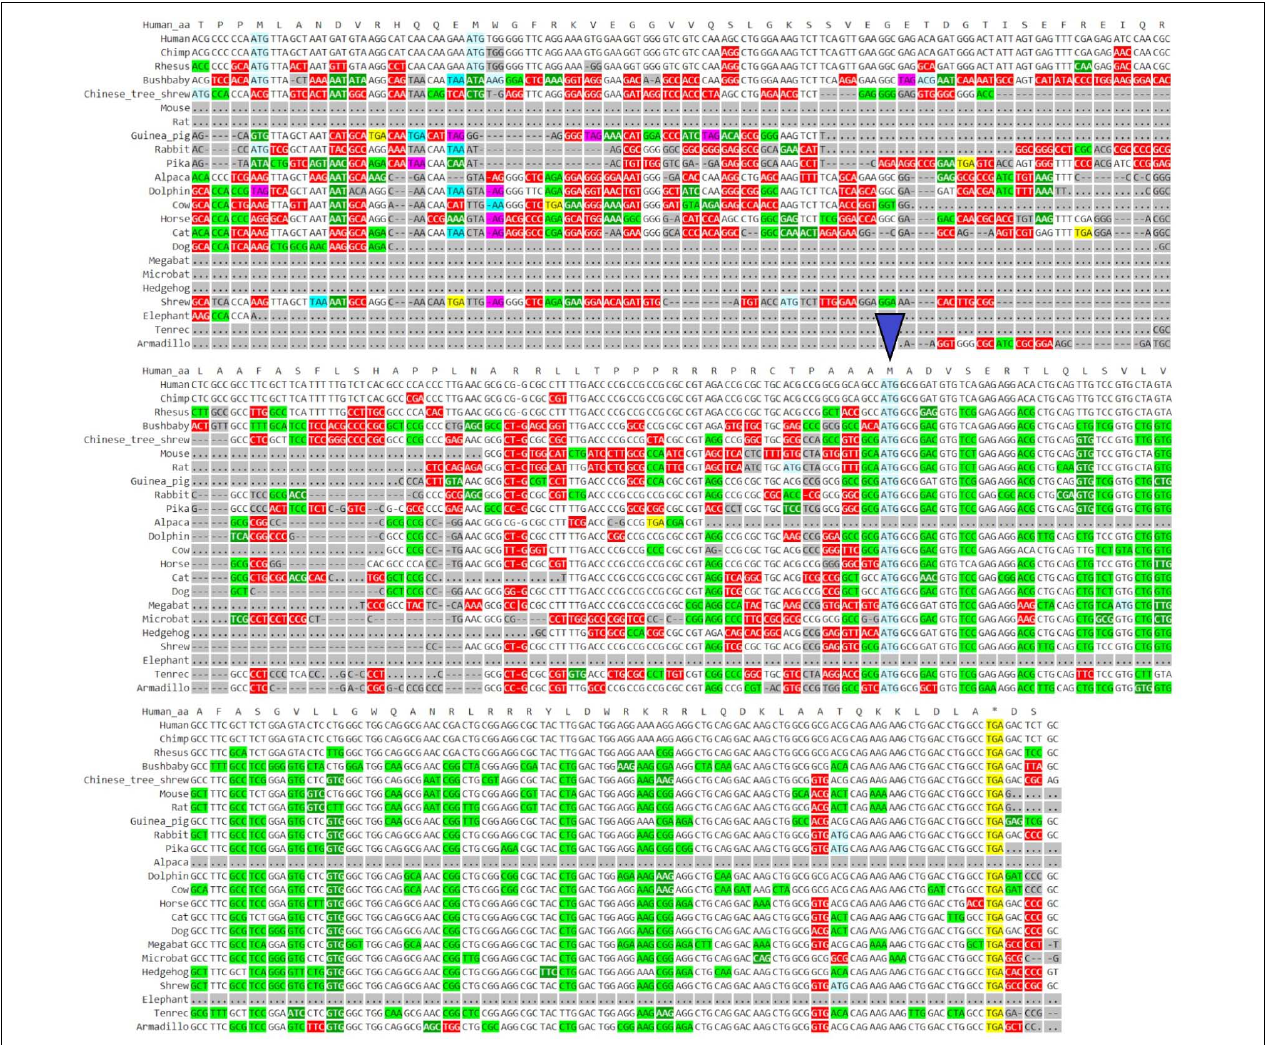
FIGURE 2 | Visualization of MTLN/LINC00116 in CodAlignView. Coding sequence of MTLN visualized in CodAlignView with a blue triangle pointing toward the third ATG start site which correlates with the region where a high ratio of synonymous codon substitutions